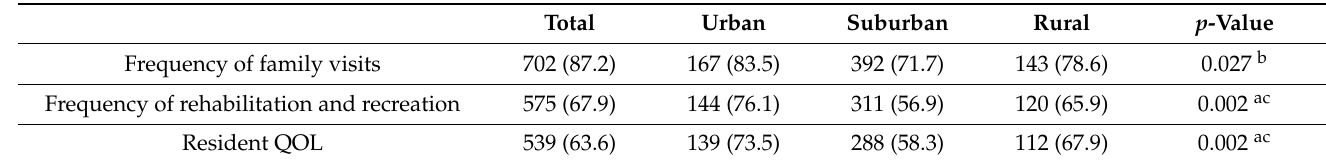
Table 1. Proportion of answers described as “decreased slightly” or “decreased substantially” in frequency of family visits, rehabilitation and recreation, and resident QOL after the start of the pandemic (N, %)